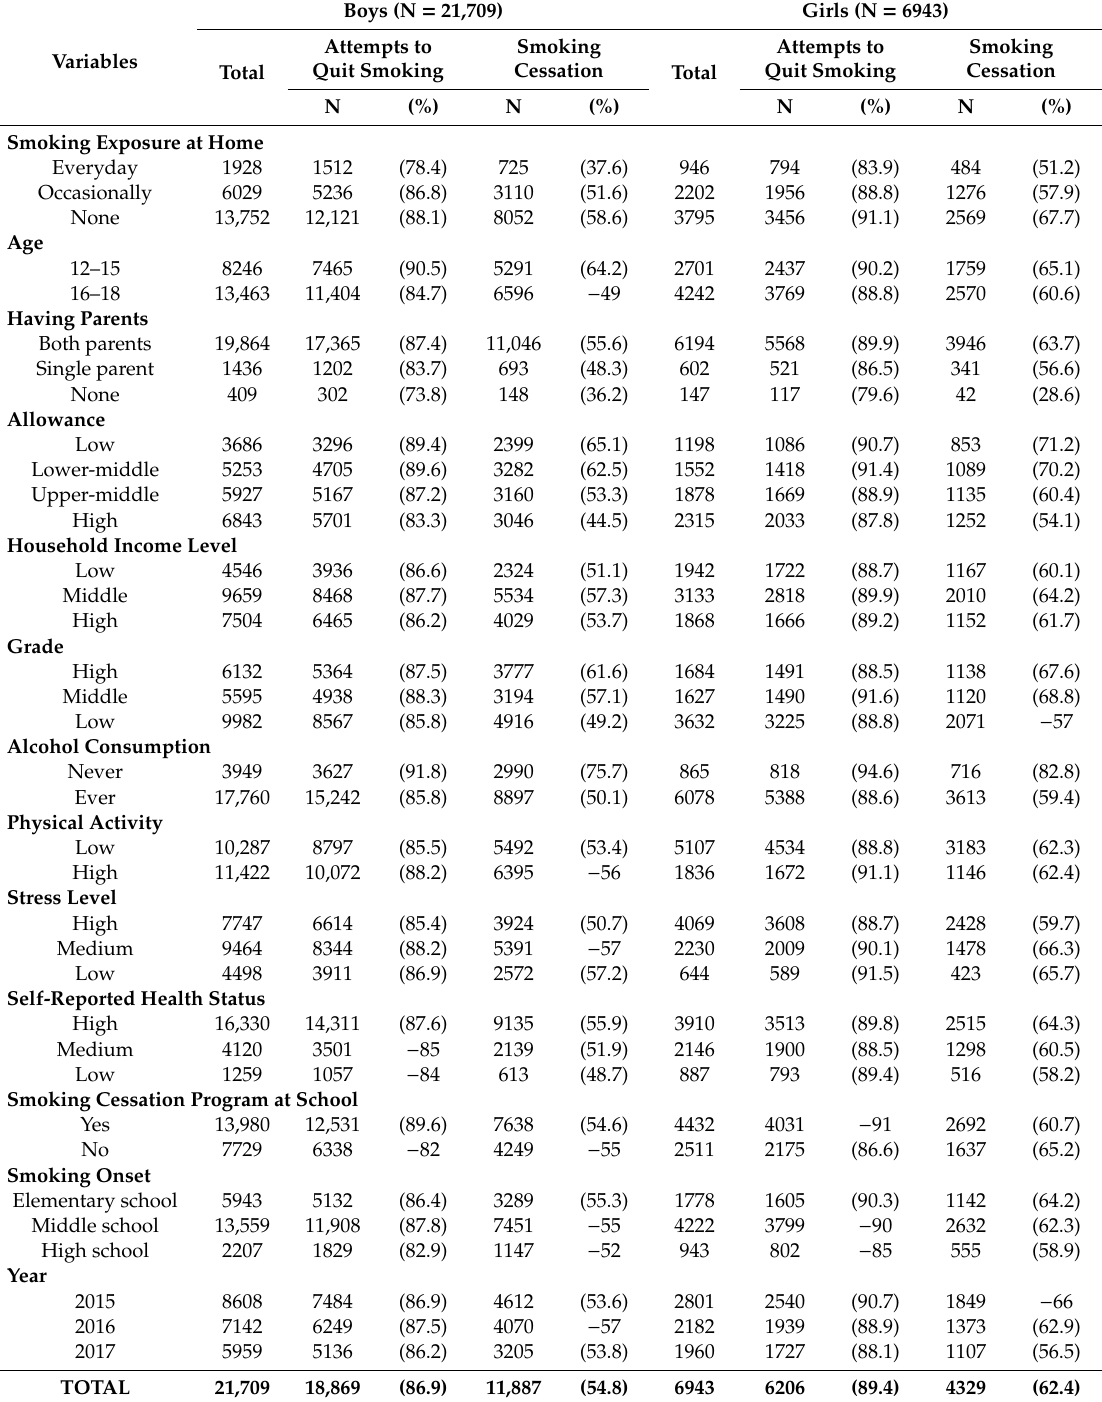
Table 1. General characteristics of the study